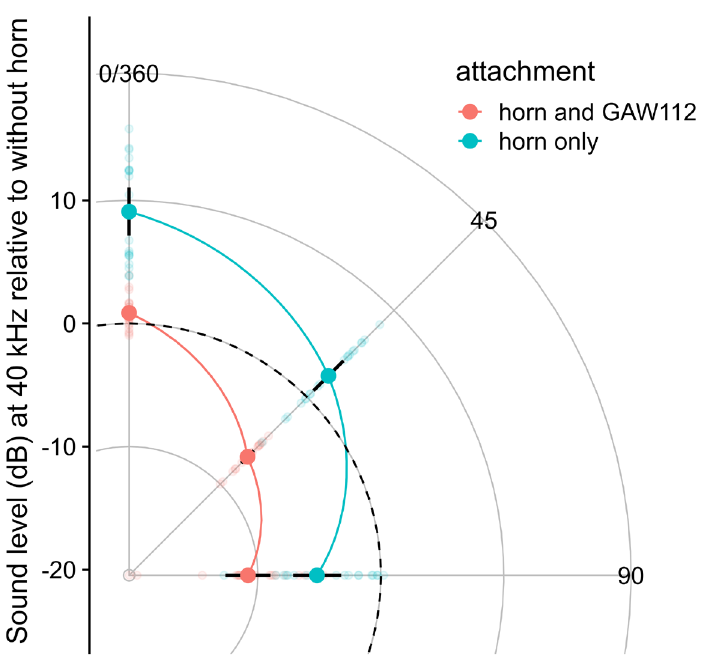
Figure 6. Partial polar diagram of the sound level amplification obtained with the ultrasonic horn for sounds coming from different angles (in degrees) to the microphone axis. The horn amplification was tested with and without a GAW112 acoustic vent placed at its